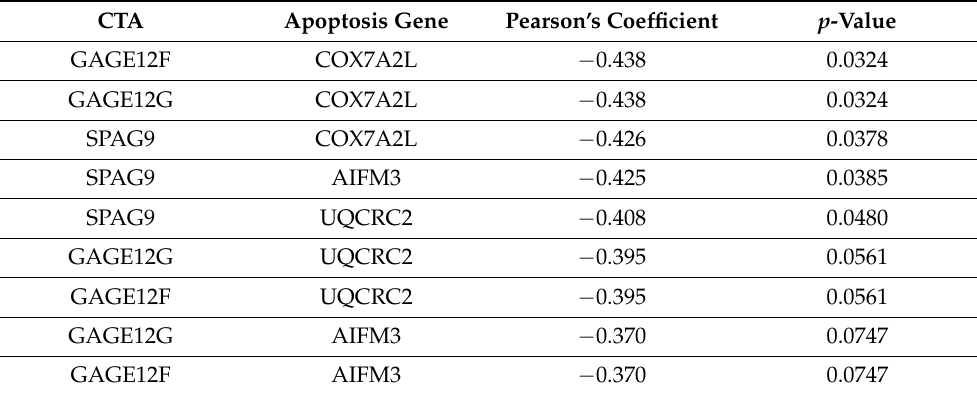
Table 2. Apoptosis-effector gene expression, inverse correlations with GBM TCR CDR3 CTA CSs for SPAG9, GAGE12F, and GAGE12G.